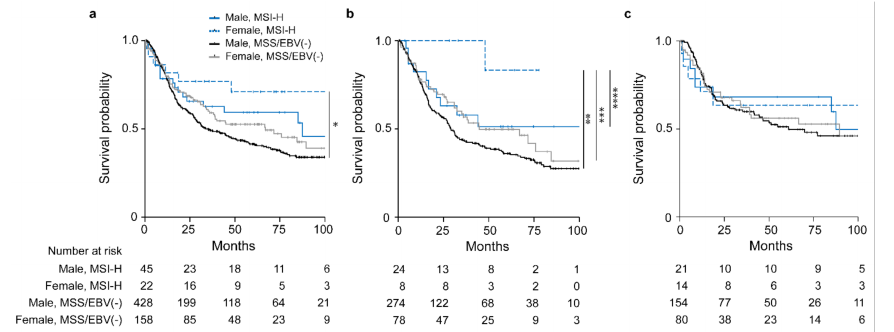
Figure 3. Discrimination of patients’ survival by sex and MSI status. Kaplan–Meier curves of female or male patients with MSI-H or MSS/EBV( − ) tumors are shown. All GC patients ( a ), patients treated with neoadjuvant CTx ( b ) and patients treated with surgery alone ( c ). * p = 0.024, ** p = 0.043, *** p = 0.085, **** p = 0.125, Cox regression was used to compare the MSI-H female group to the other sex specific molecular subgroups.